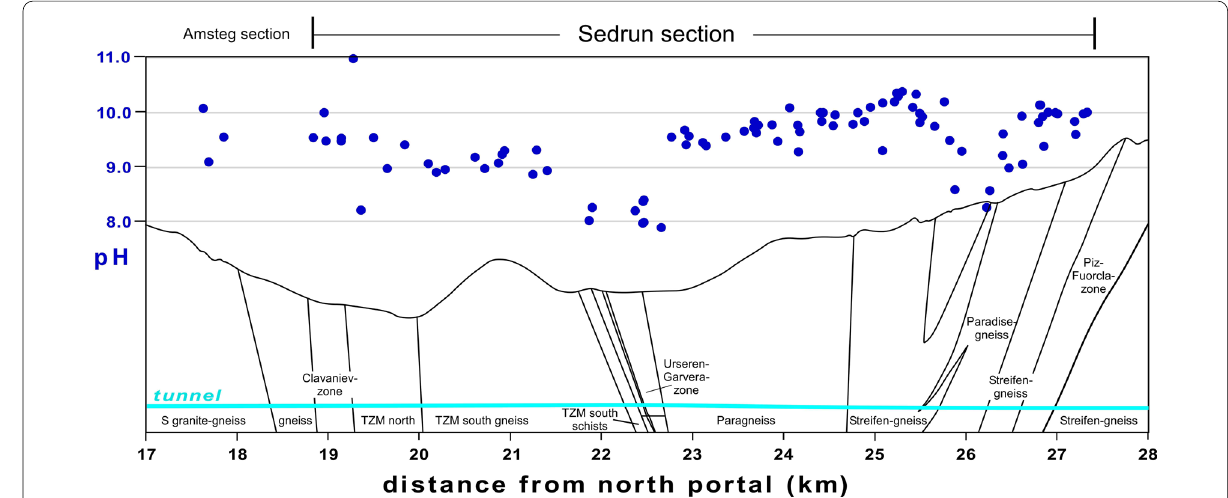
Fig. 4 pH of inflows along the